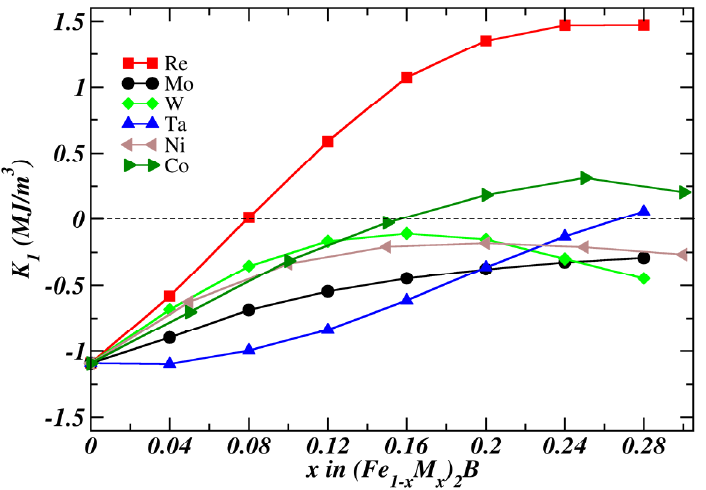
Figure 5. Anisotropy constants K 1 for (Fe 1 − x M x ) 2 B alloys (M = Co, Ni, Mo, W, Ta and Re).